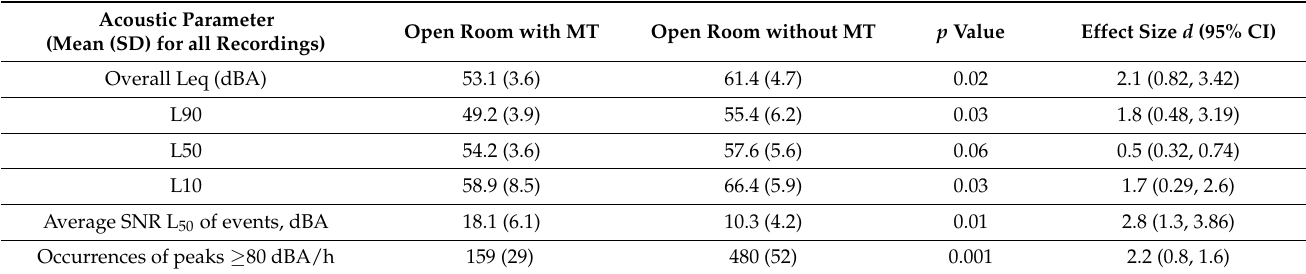
Table 2. Acoustic data.